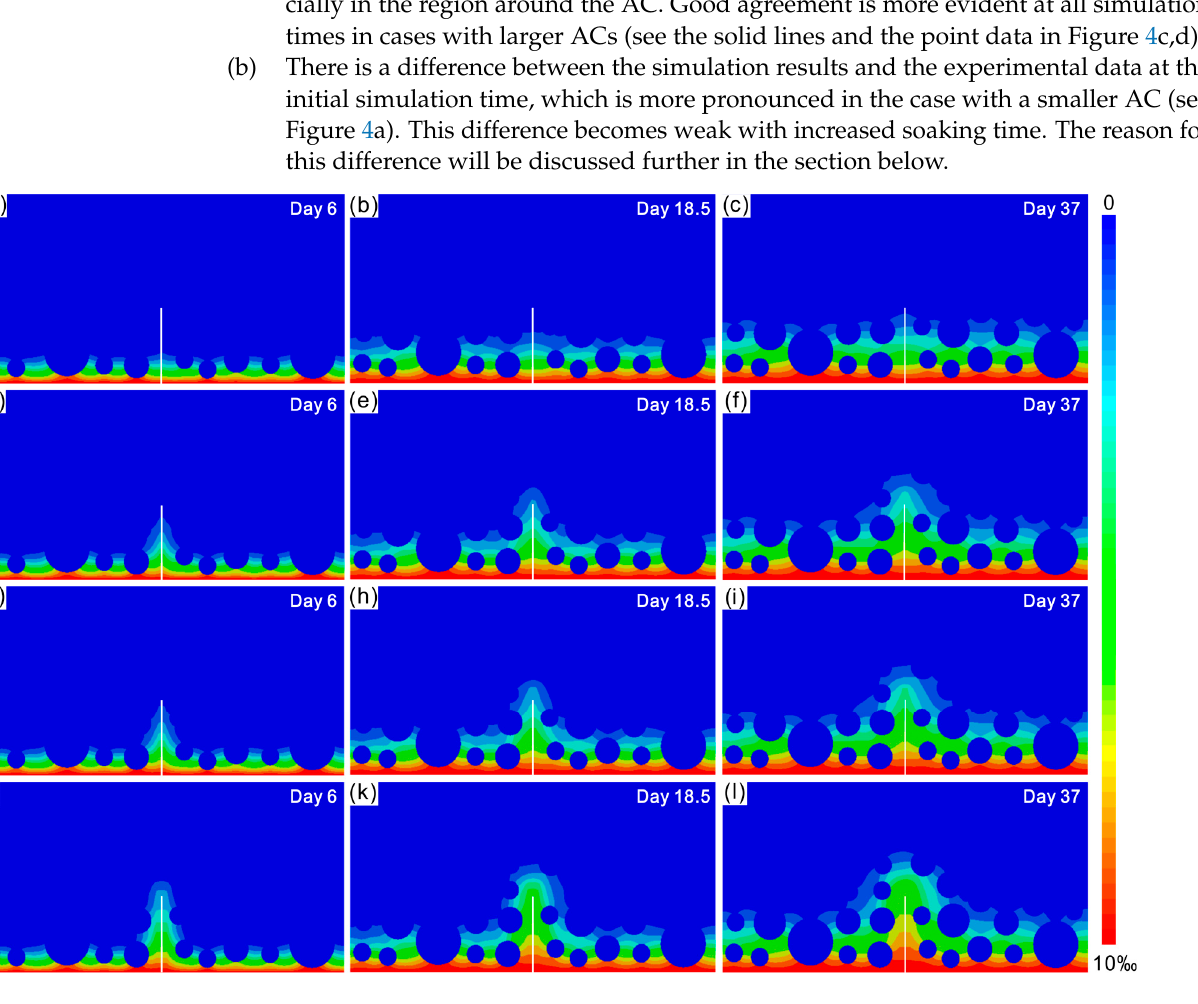
Figure 3. Distribution of chlorides in concrete with AC widths of ( a – c ) 50 µm, ( d – f ) 80 µm, ( g – i ) 100 µm and ( j – l ) 200 µm after immersion for di ff erent times. AC is highlighted with a white line. Colors from blue to red represent chloride ion concentrations from 0 to 10‰.